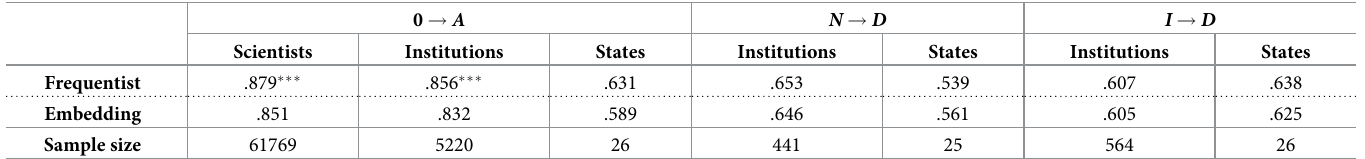
Table 2. Average AUROC for each transition, first setup. Average AUROC of the predicted transitions for scientists, institutions and states. Time windows are set as: model fitting, [1999, 2013], density estimation, [2011, 2013], and prediction testing, [2014, 2016]. Entities that did not transition during the [2014, 2016] were not included in the